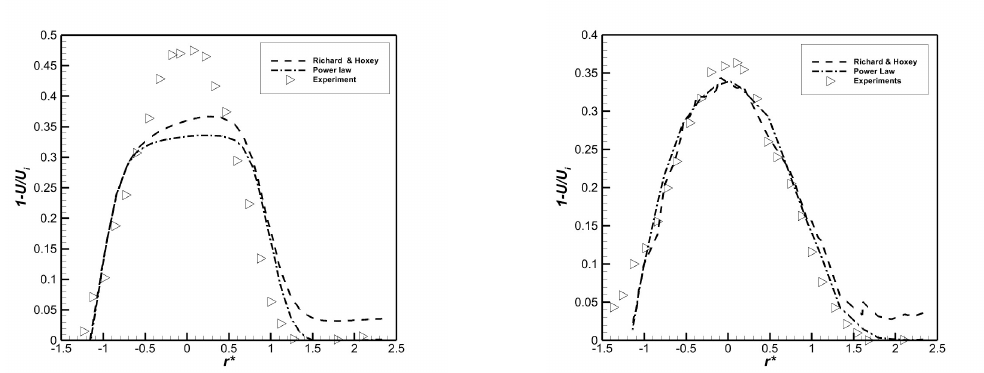
Figure 5. Power law and logarithmic velocity deficit profile in the near wake at 3 D ( left ) 5 D ( righ